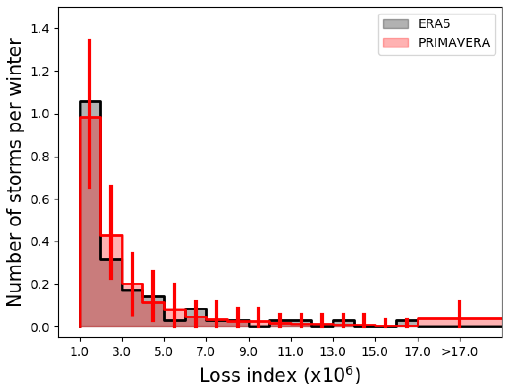
Figure 6. Distribution of the number of severe storms (LI > 1 × 10 6 ) per extended winter as a function of LI in PRIMAVERA models (red) and re-analysis (black). Vertical red lines show the 95% range in frequency estimated from 1000 35-year samples (with replacement) from the model data. Note that the last LI bin (LI > 17 × 10 6 ) is